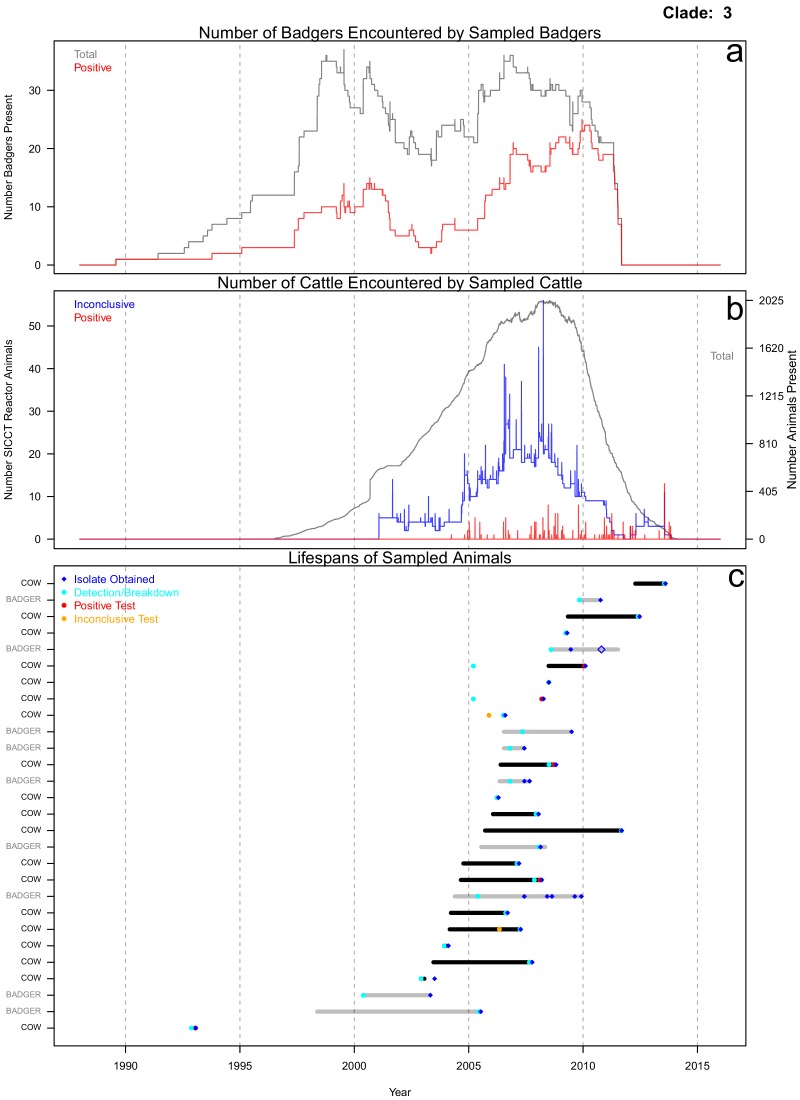
Life history summaries of the sampled and in-contact cattle and badgers associated with clade 3 in Figure 1.(a) The number of in-contact badgers associated with the sampled badgers (total in grey, number of animals that have tested positive in red). (b) The number of in-contact cattle associated with the sampled cattle (total in grey (right axis), number of animals that reacted inconclusively (red) or positively (blue) to routine skin test (left axis). In-contact animals are those that lived in the same herd (cattle) or social group (badgers) at the same time as the sampled animals. (c) The recorded lifespans of the sampled cattle (black horizontal bars) and badgers (grey horizontal bars) associated with clade 3.